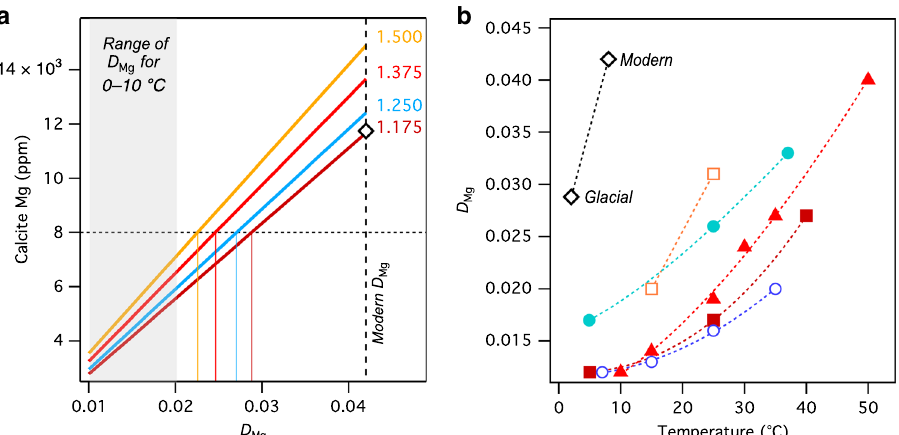
Fig. 6 Modelled magnesium partition coef fi cients from CD3. a CD3 Mg concentrations derived from a range of Mg partition coef fi cients ( D Mg ) and four hypothetic pool-water Mg/Ca ratios (values in mol/mol displayed next to each line). The modern D Mg (0.042) is shown by the long-dash vertical line. The black diamond shows the mean modern calcite concentration value (~11,750 p.p.m.) and the mean pool-water Mg/Ca value (1.175 mol/mol) 33 . The short-dash horizontal line is the minimum measured Mg concentration (8000 p.p.m.) from Fig. 5d. Each coloured solid vertical line gives the D Mg value for the corresponding pool-water Mg/Ca at 8000 p.p.m. The grey panel shows the range of D Mg values for 0 – 10 °C from previously published studies 33 . b Published experimentally derived D Mg – temperature relationships (coloured symbols) compared to CD3 (black diamonds). Open and closed coloured symbols are from cave-analogue and seawater-analogue experiments respectively (green solid circles, Burton and Walter 77 ; red solid triangles, Oomori et al. 78 ; solid brown squares, Mucci 79 ; open blue circles, Day and Henderson 80 ; open orange diamonds, Huang and Fairchild 81 ). The modern CD3 value is based on Drysdale et al. 33 ; the glacial CD3 value is the maximum possible D Mg assuming a MIS 6 glacial cave temperature of 6 °C below present (i.e., 2 °C) and a pool-water Mg/Ca value (1.175 mol/mol) equivalent to